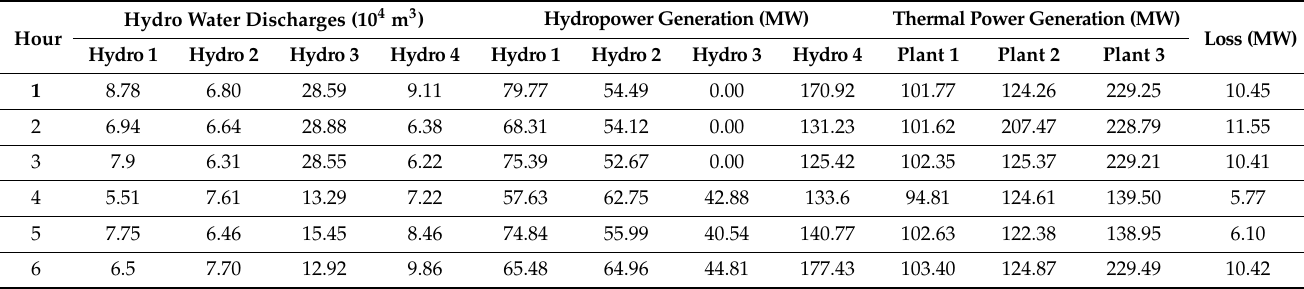
Table 7. EPC minimization schedule results with DOGSA for Test